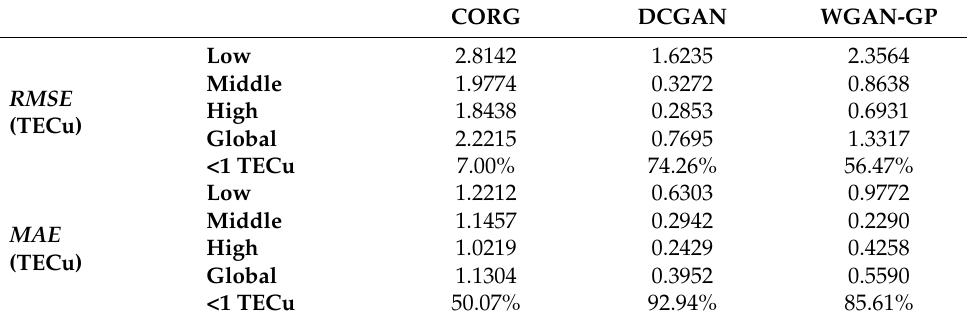
Figure 5. The RMSE and MAE for spatial TEC estimation in 2014. The 71 × 73 grids are interpolated with a spline to demonstrate a finer global feature of ionospheric TEC . Table 2. The mean values for RMSE and MAE in 2014.